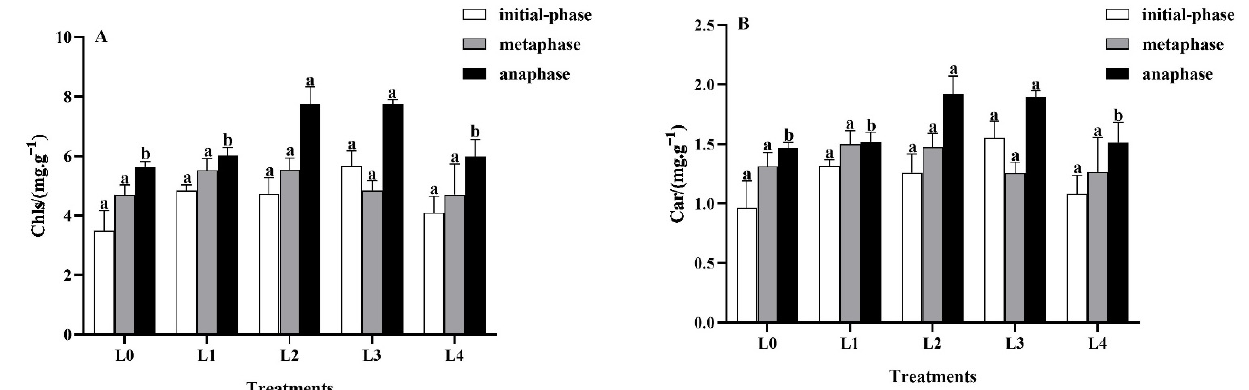
Figure 2. Effects of different light intensities on the contents of total chlorophyll (Chls, ( A )) and carotenoids (Car, ( B )) in Ma bamboo. Note: L0, L1, L2, L3 and L4 refer to 100%, 40%, 30%, 20%, and 10% of natural light, respectively. Values are the means ± SE of four replicates per treatment. Different letters indicate significant differences between treatments at the same shooting period ( p < 0.05).